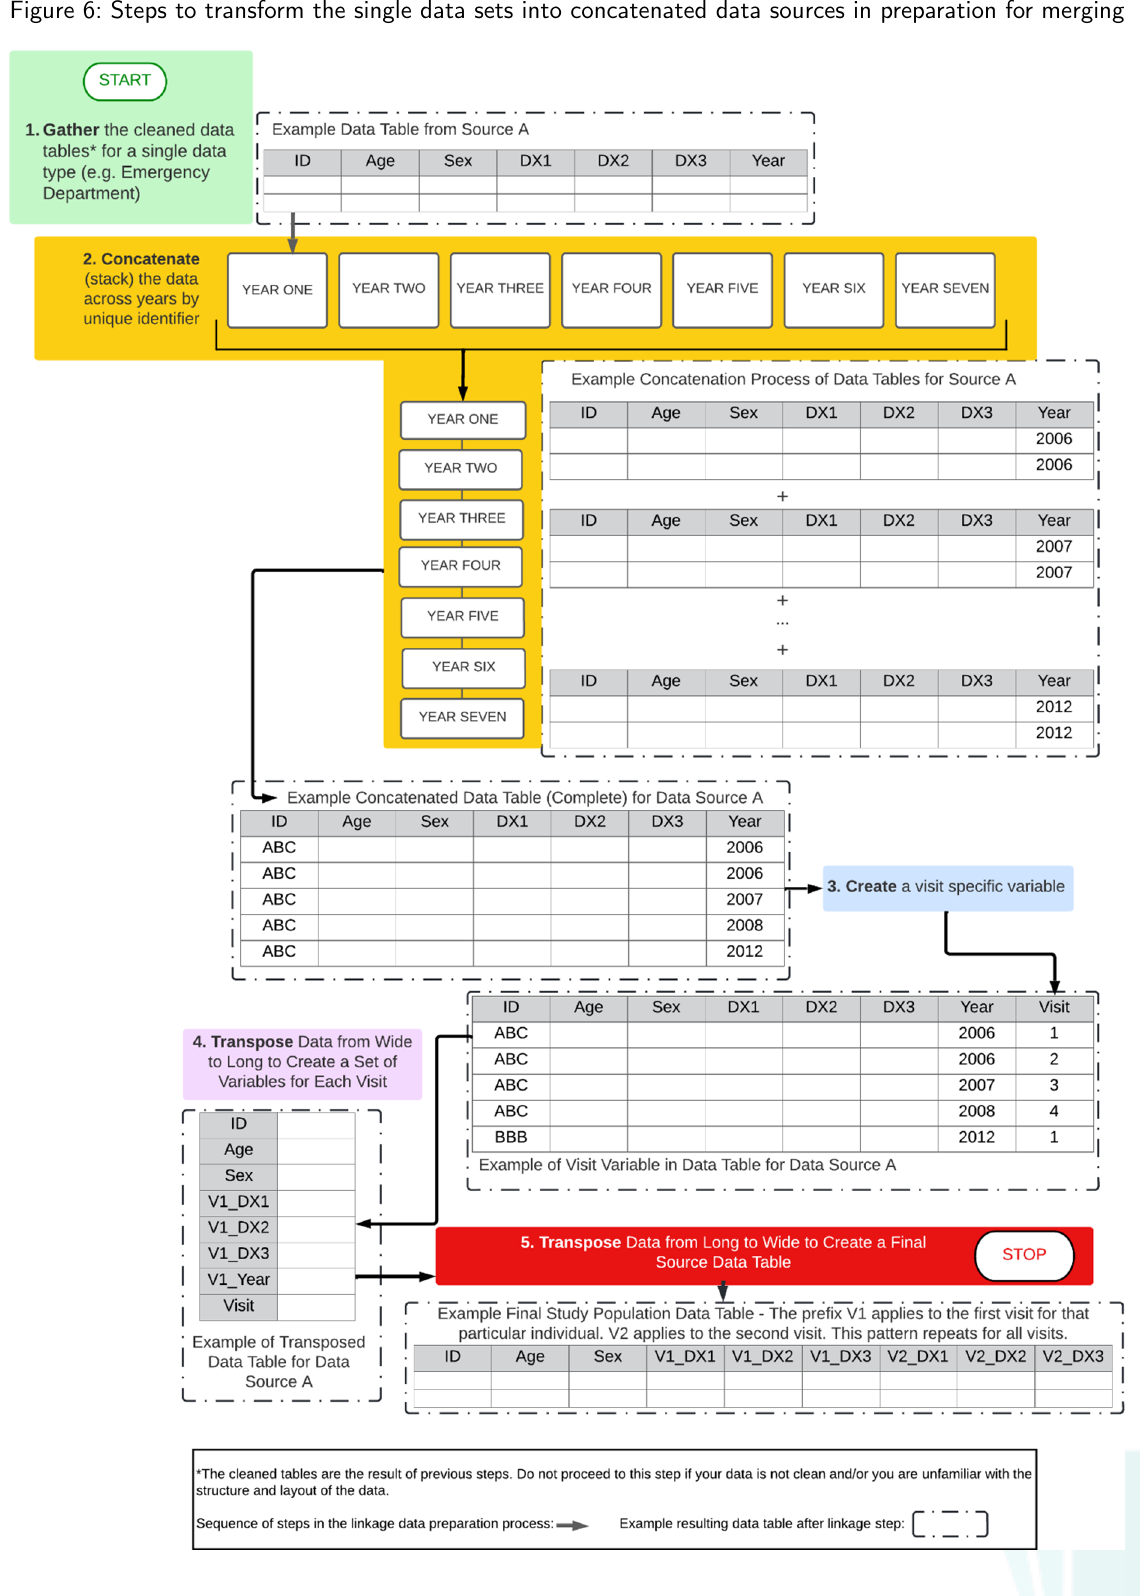
Figure 6: Steps to transform the single data sets into concatenated data sources in preparation for